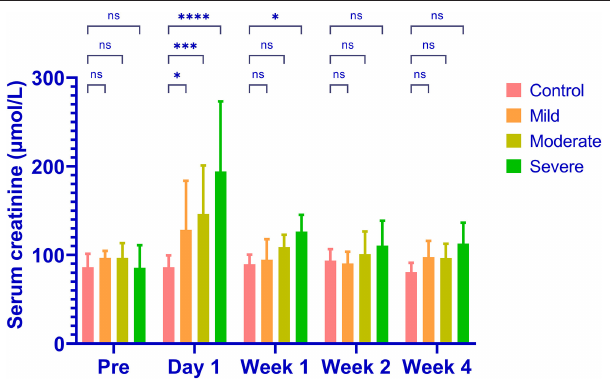
mild (a), moderate (b) and severe (c) AKI groups are shown in Figure 2 . The calculated renal dR2’ maps within 1 h after the embolization procedure, T2w images and histological results at 1 month of each group are displayed. The histological findings reflected the severities of AKI. The serum creatinine levels elevated after embolization and decreased to baseline levels after 4 weeks in AKI groups ( Figure 3 ). The levels of serum creatinine at Day 1 were aligned with the severities of AKI (control 86.20 ± 10.71 µ mol/L, mild 128.4 ± 44.44 µ mol/L, moderate 146.2 ± 44.02 µ mol/L, severe 194.2 ± 63.59 µ mol/L).